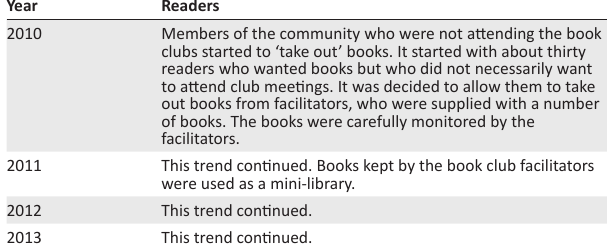
Table 7: Themes identified from monthly and yearly reports and field notes: Readers came forward who did not attend club